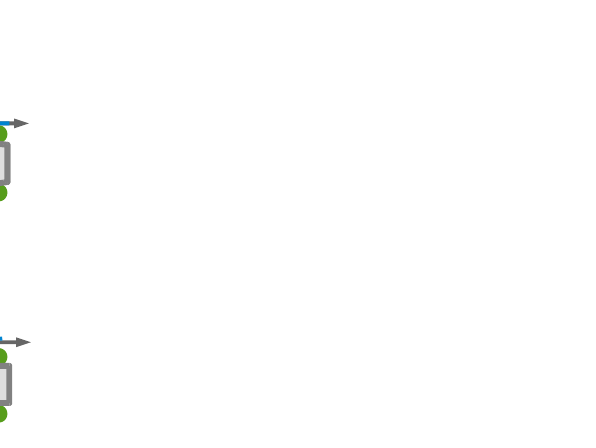
Figure 37. Energy trapping allows to mount resonators at the edge with little damping. When the resonator is thicker in the center than at the edge, the shear vibration is confined to the center. Ideally, the amplitude distribution is smooth ( top ). Experiments often evidence small-scale variability ( bottom , [172,186]). u 2 ( r ) is the weight function to be applied in area averaging following Equation (26).